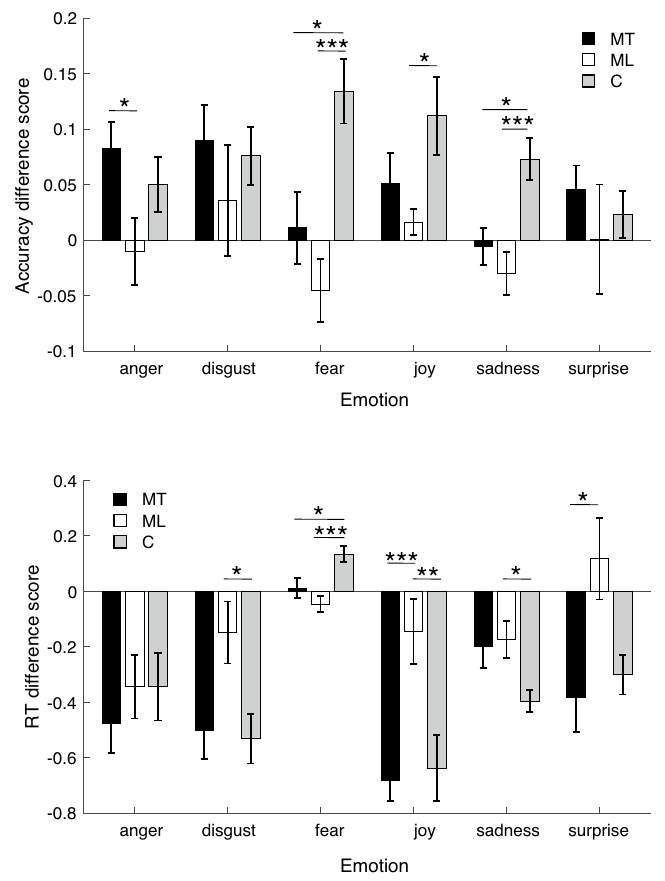
Figure 3. Improvement in emotion recognition accuracy (top panel) calculated as accuracy difference score (correct responses, last testing session—first testing session). Positive numbers represent an improvement in accuracy by the end of the study, while negative numbers represent a decrease in accuracy. RT difference score for correct responses (bottom panel) calculated as difference between RT at the last testing session and that measured at the first testing session. Negative numbers represent an improvement in RT by the end of the study, while positive numbers a worsening in RT. Numbers around zero indicate no difference in accuracy or RT. MT = music training group; ML = music listening group; C = control group. Error bars represent errors standard of the means. * p ≤ 0.05, ** p ≤ 0.01, *** p ≤